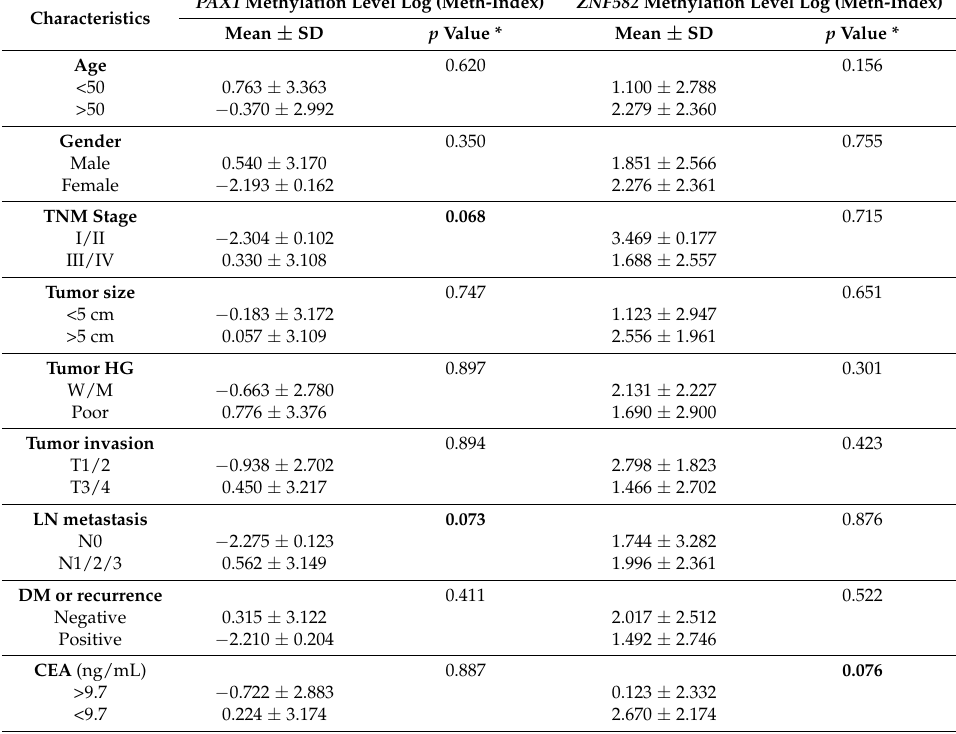
Table 4. Correlation between methylation levels of PAX1 and ZNF582 in cancer tissues and clinical characteristics in 14 ESCC patients ( n =